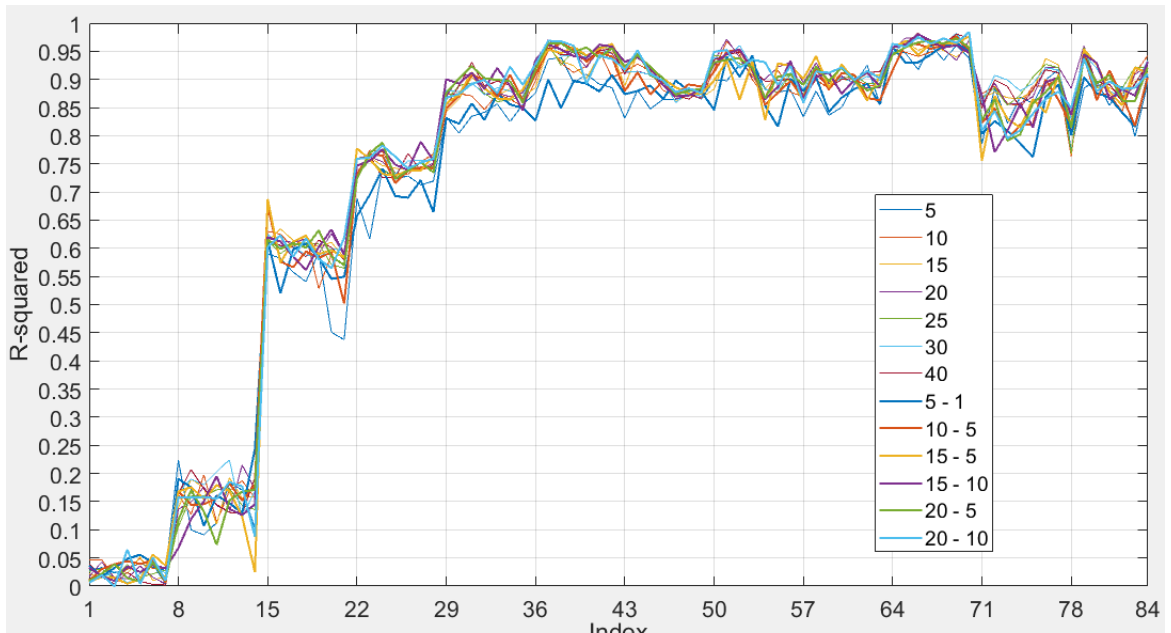
Figure 12. R 2 values for neural network regression models for Δ P . Table 5. Variables used in the second step of NN